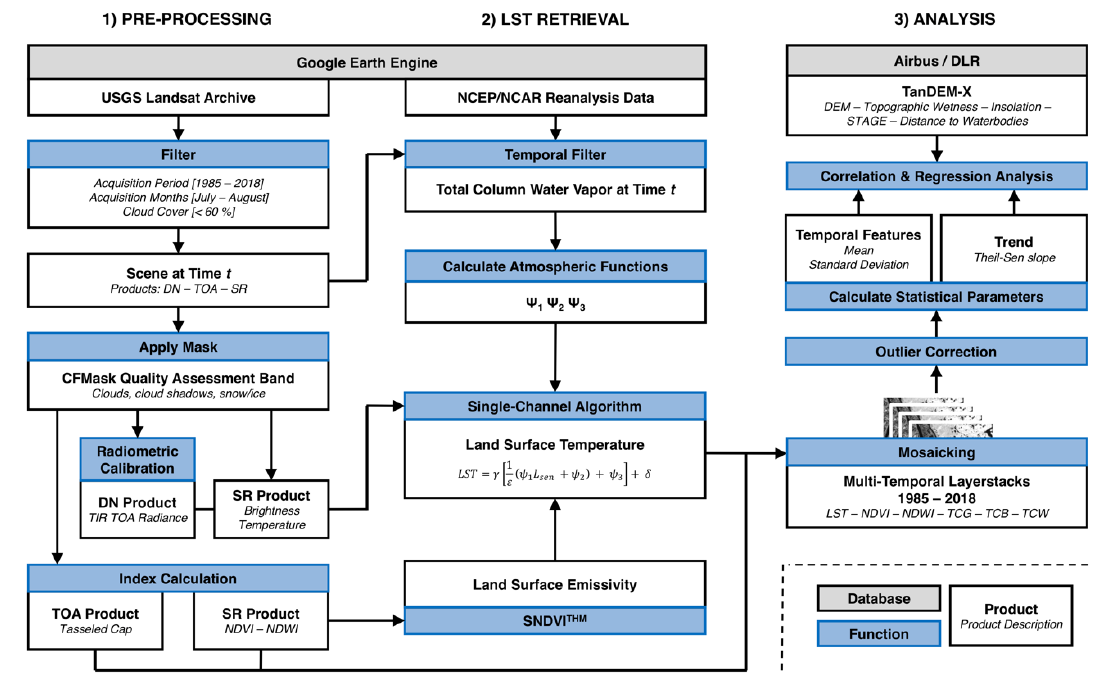
Figure 3. Flowchart of the processing steps, including pre-processing the data, retrieving Land Surface Temperature (LST), and calculating the statistical parameters in order to conduct the correlation, regression, and trend analysis.